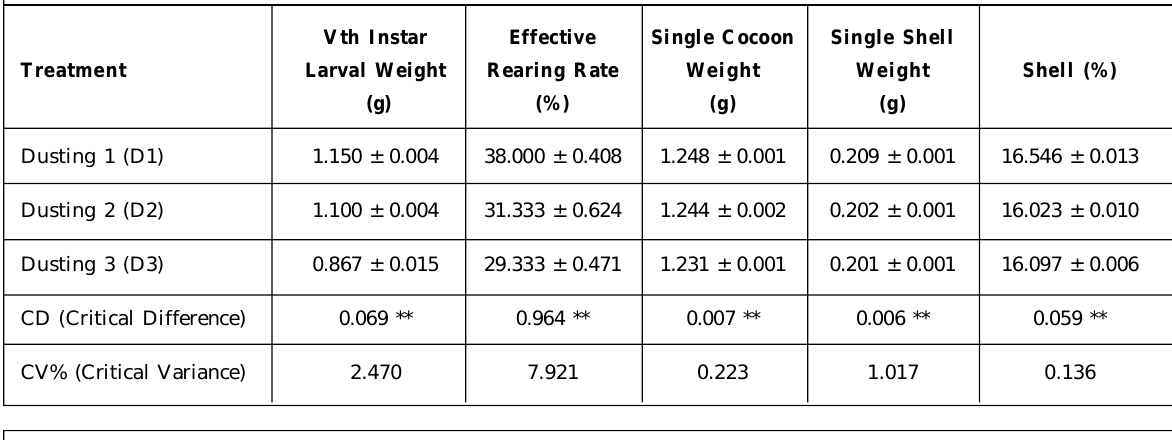
Table 2: Rearing - I: Economic parameters after challenge with Bm NPV during June-July, 2017-20